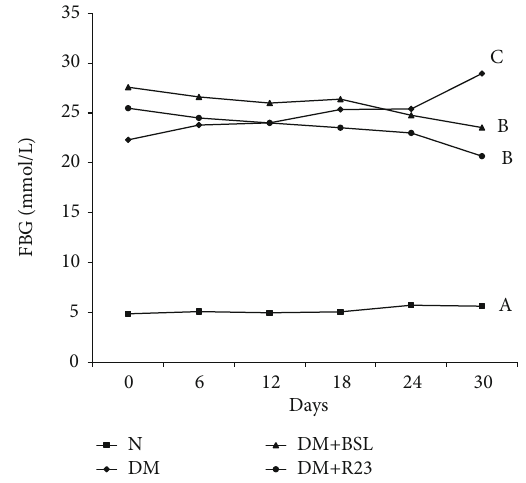
Figure 2: E ff ect of L. rhamnosus BSL and L. rhamnosus R23 on fasting blood glucose in experimental groups after intervention period for 30 days. The values are expressed as the means ± SD ( n = 6 ). The values with di ff erent superscript letters are signi fi cantly di ff erent ( P < 0 : 05